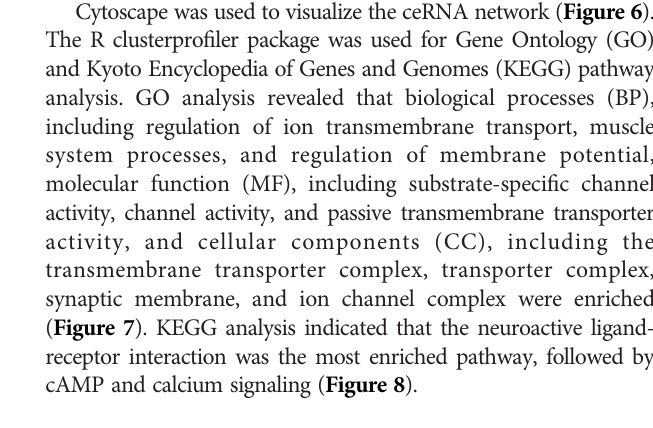
TABLE 1 | The relationship between the expression level of hsa_circ_0001675 and clinicopathological characteristics of HNC patients.